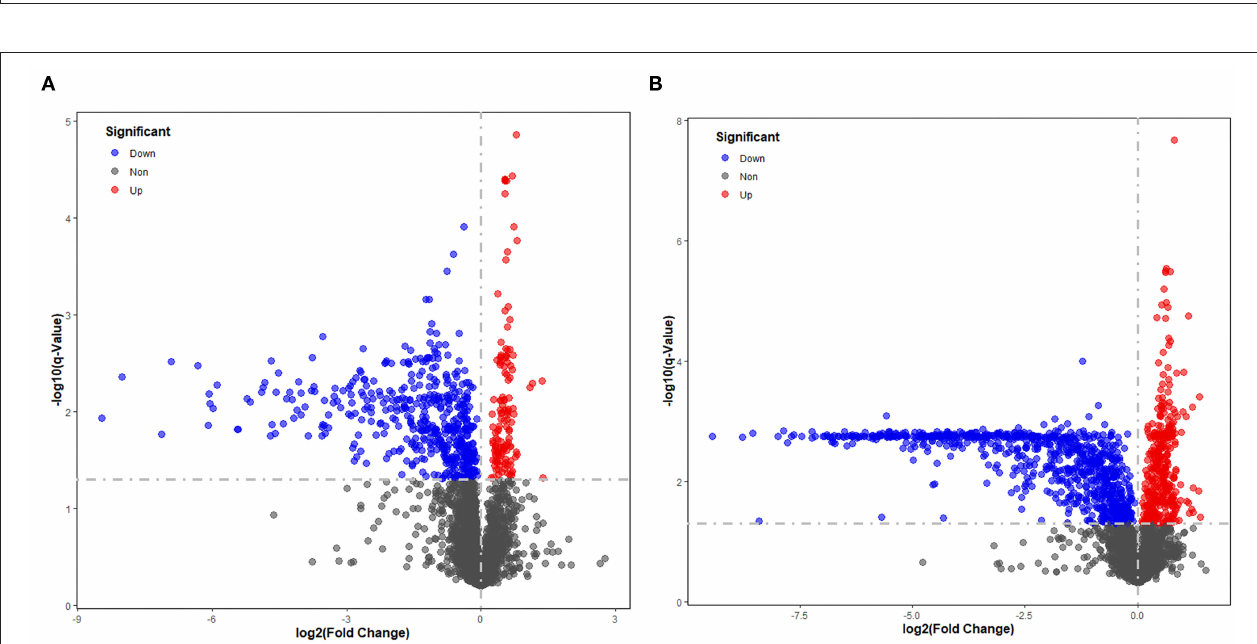
FIGURE 1 | Multivariate statistical analysis. An OPLS-DA model showed that the AD patients (red circle) could be separated from the NAD (blue square) with little overlap in the negative mode (A) and positive (B) . Validation of the OPLS-DA model by the 200-time permutation test suggested that the original model was valid and not overfitted in negative mode (C) and positive (D) .